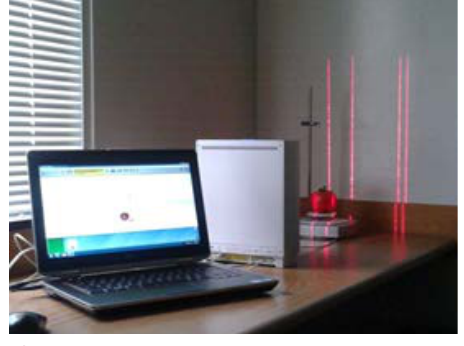
Figure 1 NextEngine 3-D scanner in the Media Commons